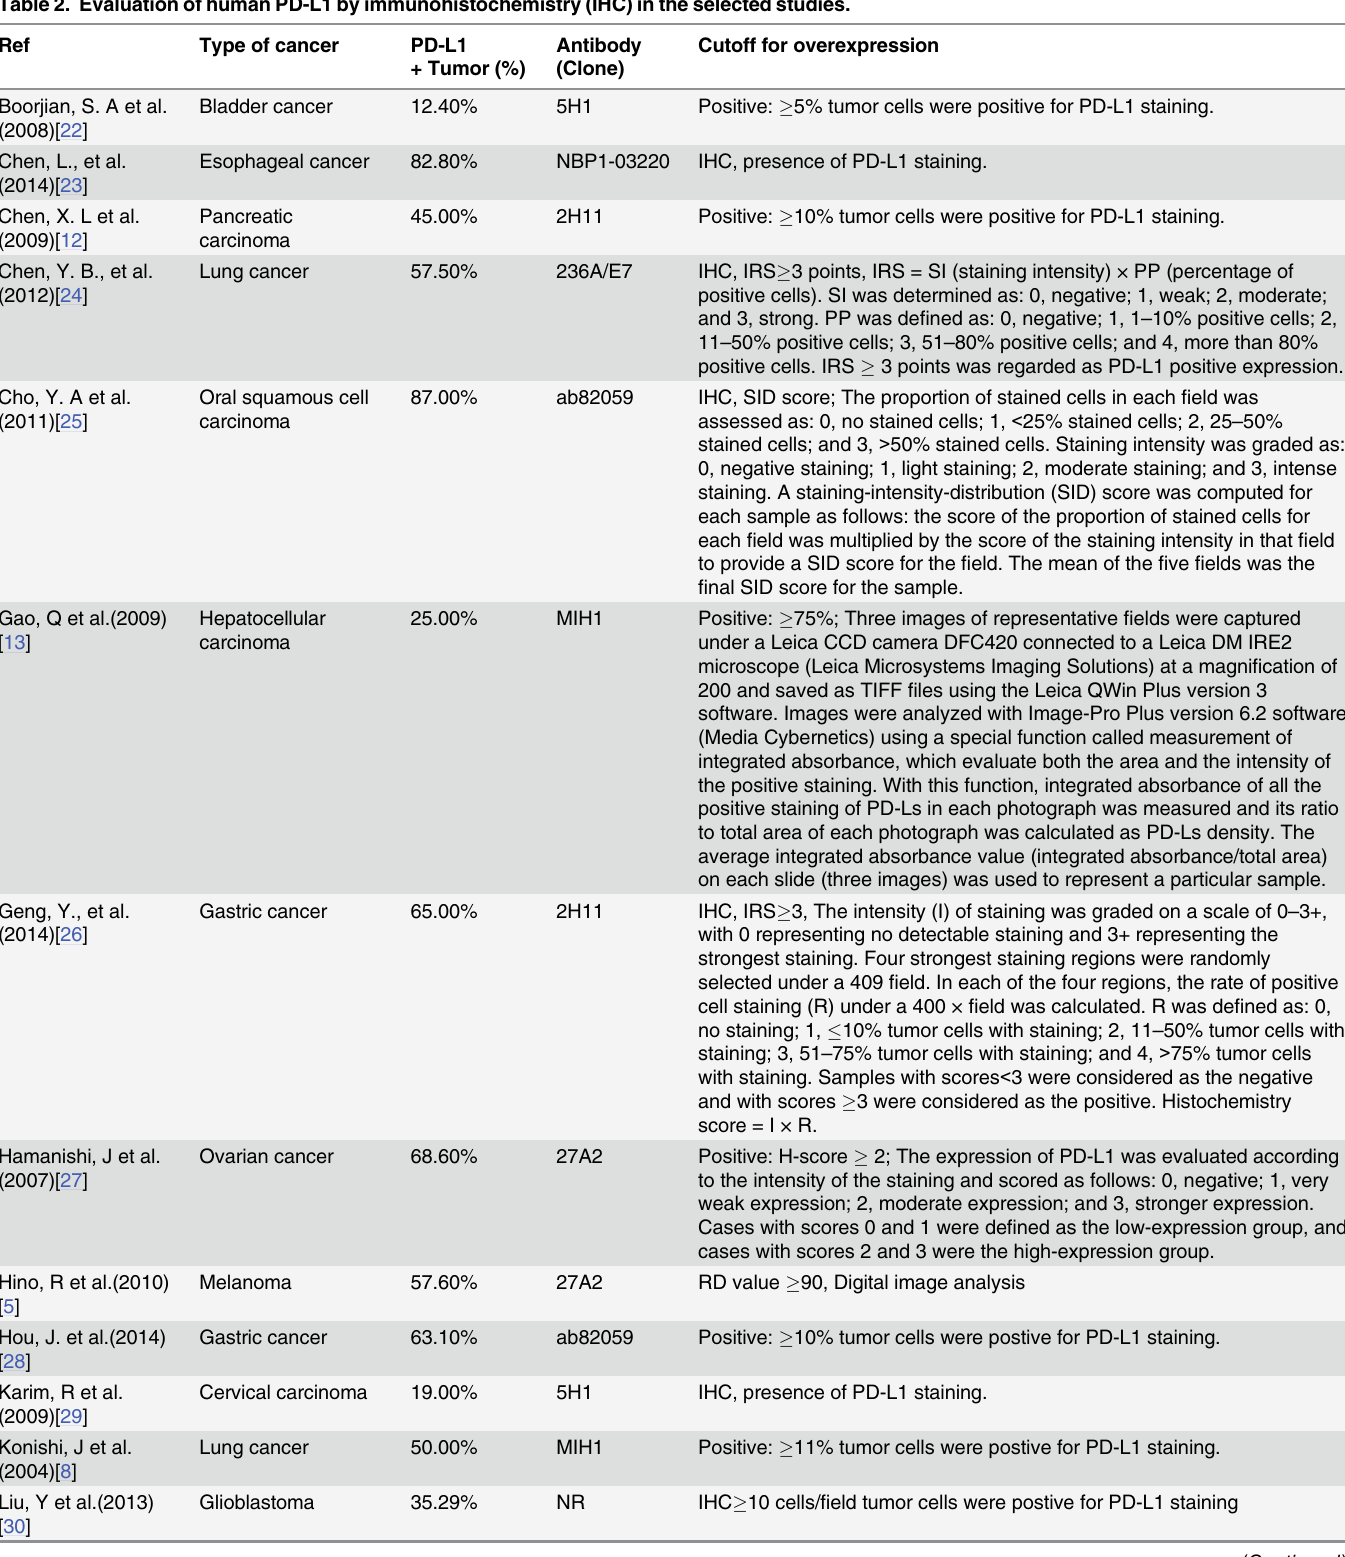
Table 2. Evaluation of human PD-L1 by immunohistochemistry (IHC) in the selected